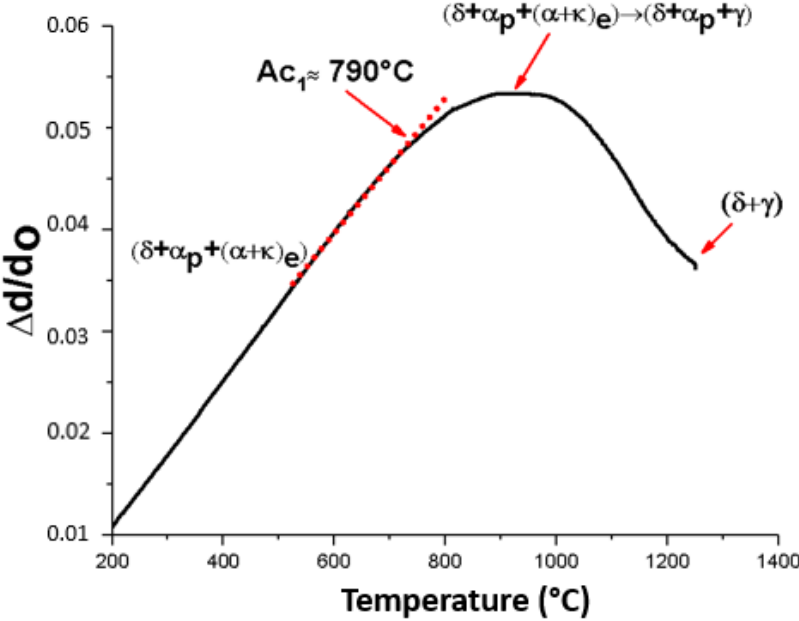
Figure 1. Dilatometric curve of the investigated Fe-Mn-Al-C alloy highlighting the phases present in each region ( δ = δ -ferrite; α p = proeutectoid ferrite; ( α + k) e = eutetoid microconstituent; γ = austenite; k = k-carbide).